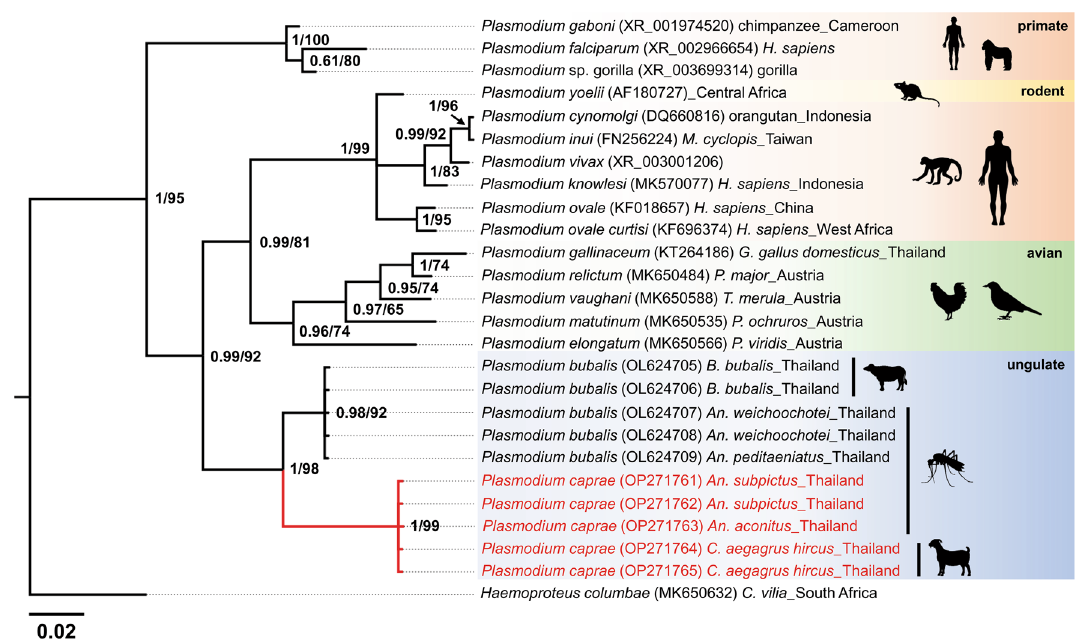
Figure 4. The phylogenetic position of P. caprae obtained in this study using a partial 18S rRNA gene (335 bp). All sequences were rooted with Haemoproteus columbae . Posterior probabilities and bootstrap values (≥ 0.61/65) are given in the nodes. The length of the substitutions/site (0.02) is